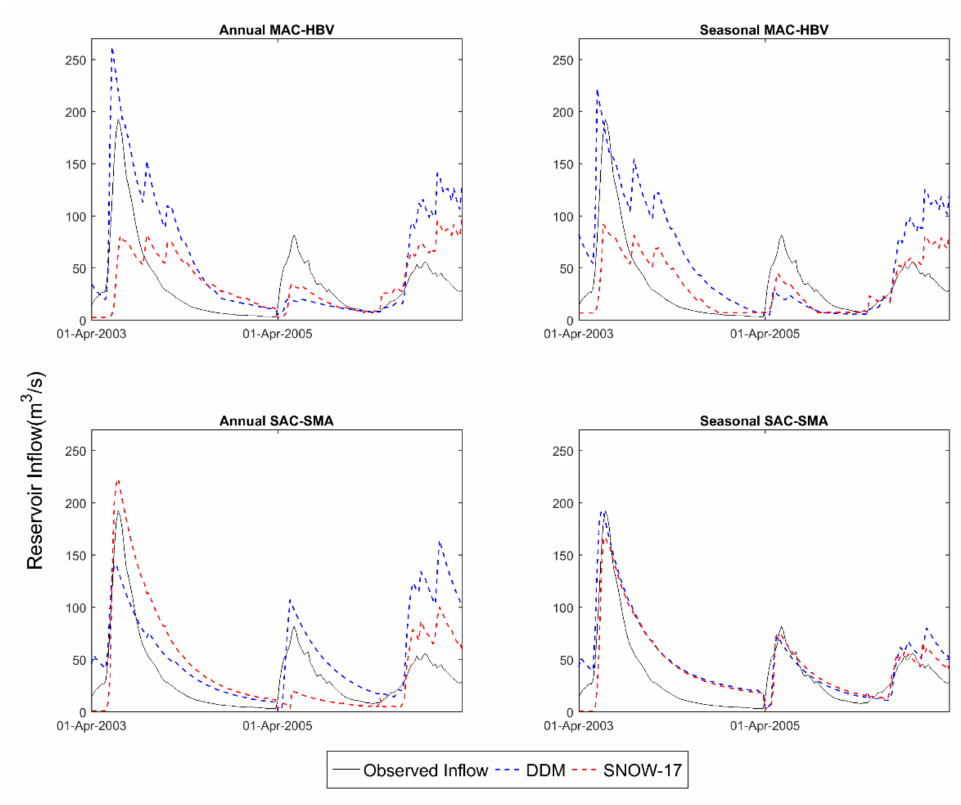
Figure 11. Validation hydrographs showing spring season inflow simulations for